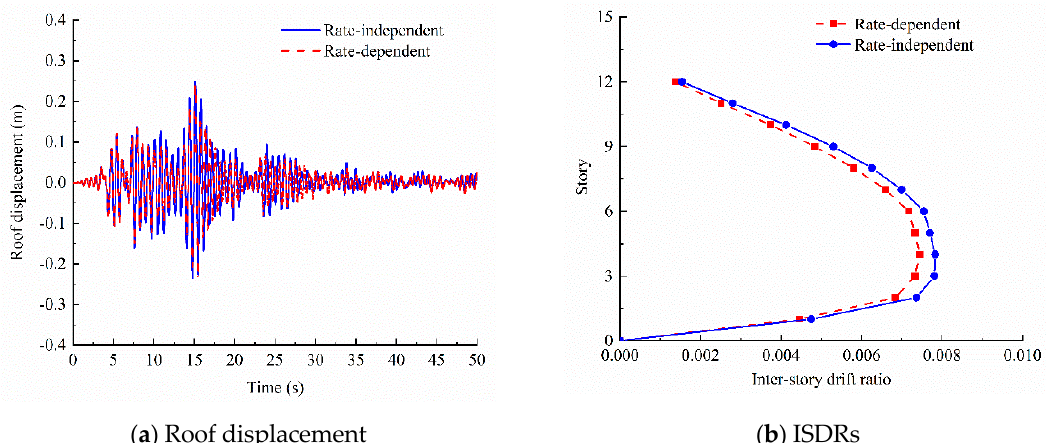
Figure 8. Comparison of the rate-dependent and rate-independent numerical results of roof displacement and ISDRs (Taft PGA = 0.4 g).